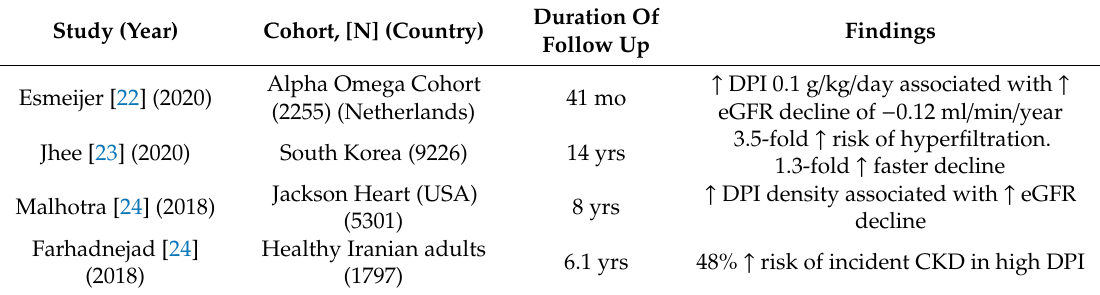
Table 1. Selected studies of high-protein and kidney function. DPI: dietary protein intake; CKD: chronic kidney